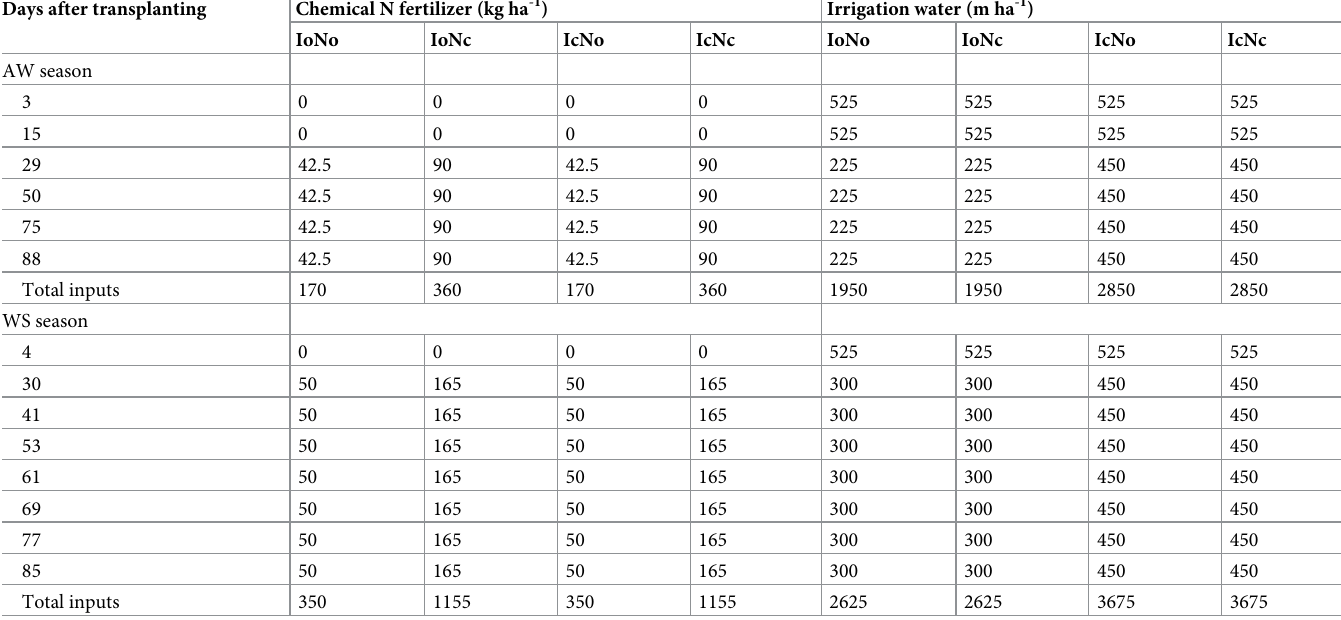
Table 1. The application amount of chemical fertilizer and irrigation water under different treatments in the autumn-winter (AW) and winter-spring (WS) crop- ping seasons. Days after transplanting